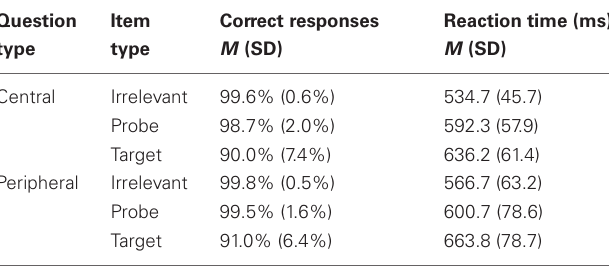
Table 1 | Average proportion of correct responses and reaction